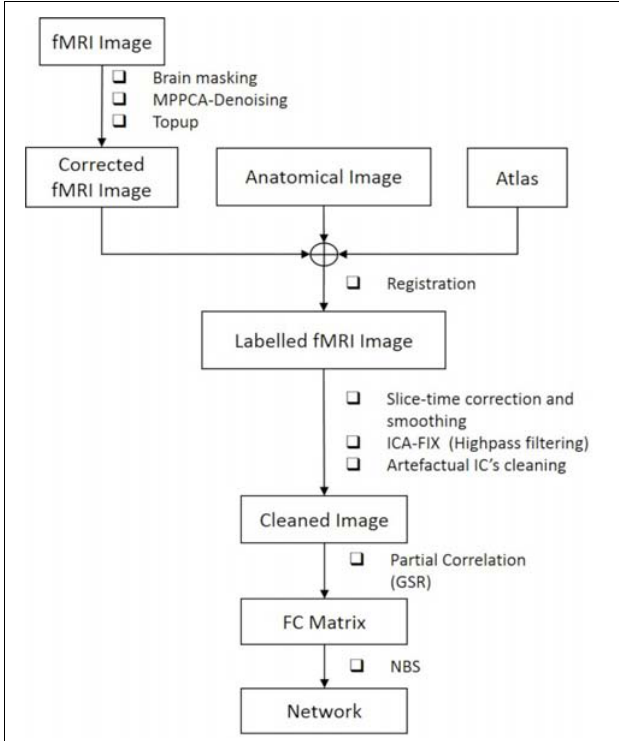
FIGURE 2 | The proposed pipeline for rs-fMRI data processing.